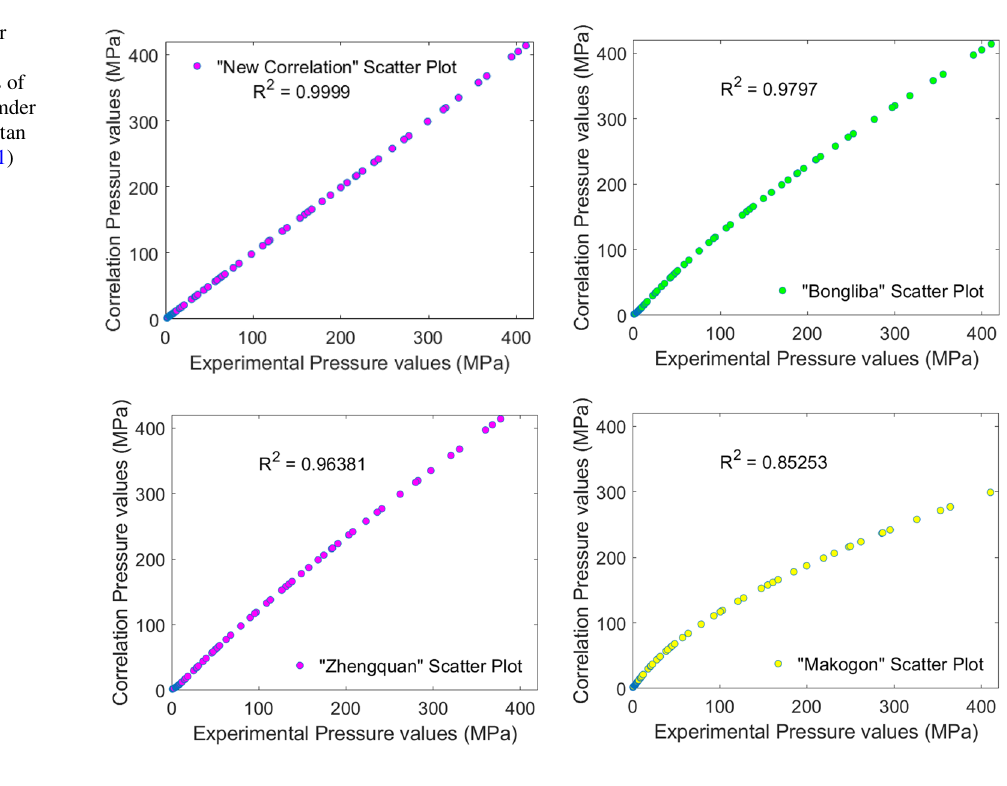
Table 10 Statistical error for temperature range: 260 ≤ T ≤ 320 K